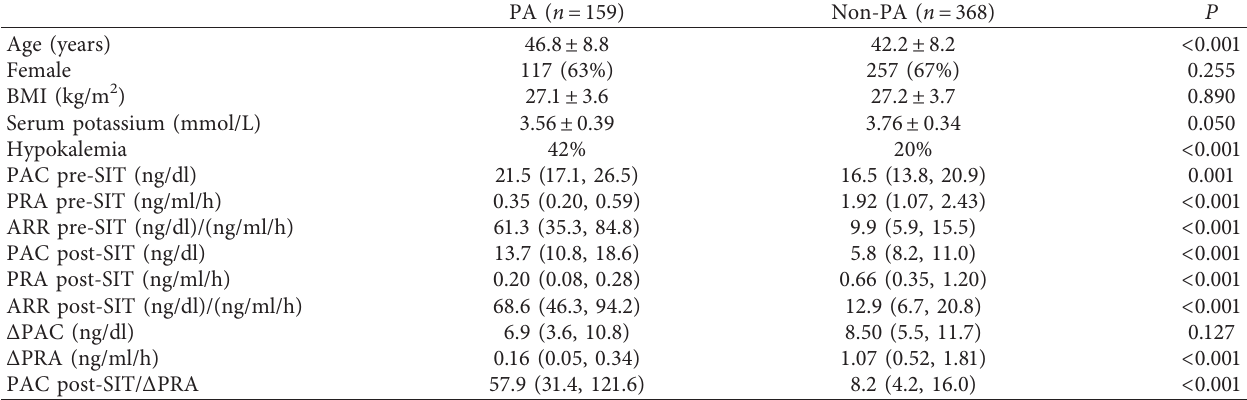
Table 1: Comparison of characteristics and SIT parameters in PA and non-PA